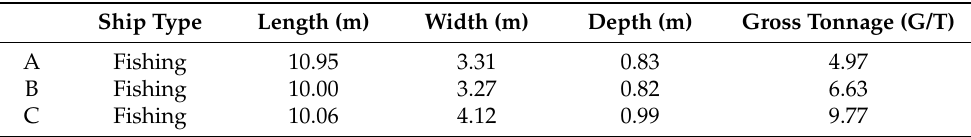
Table 2. Detailed specifications of target ships for the real ship test.